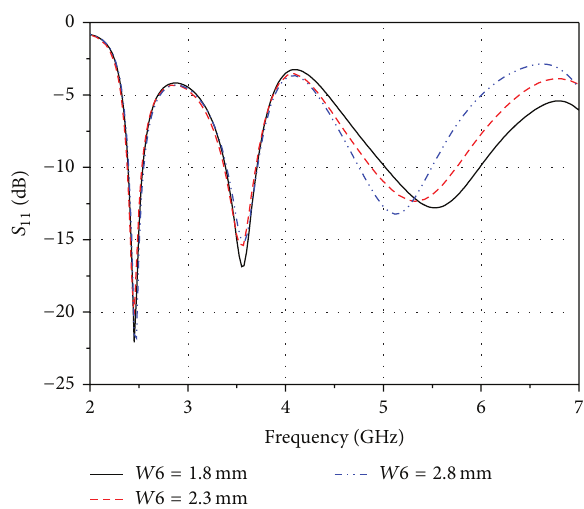
Figure 6: Measured 𝑆11 of the proposed tri-band